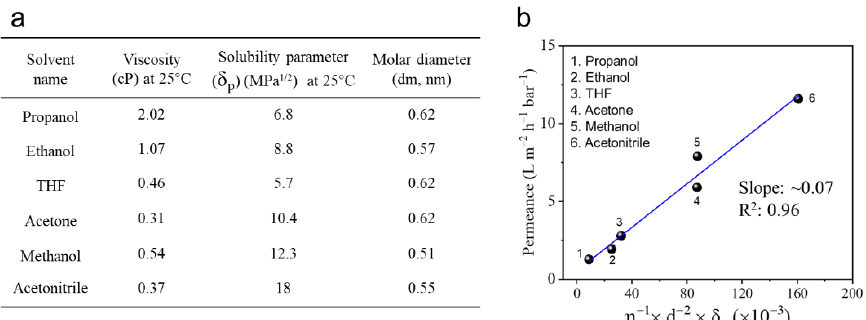
Figure 7. ( a ) Properties of solvents used in this work and their ( b ) correlation with solvent permeance of TFC PA-3 membranes (one membrane for every single data point).